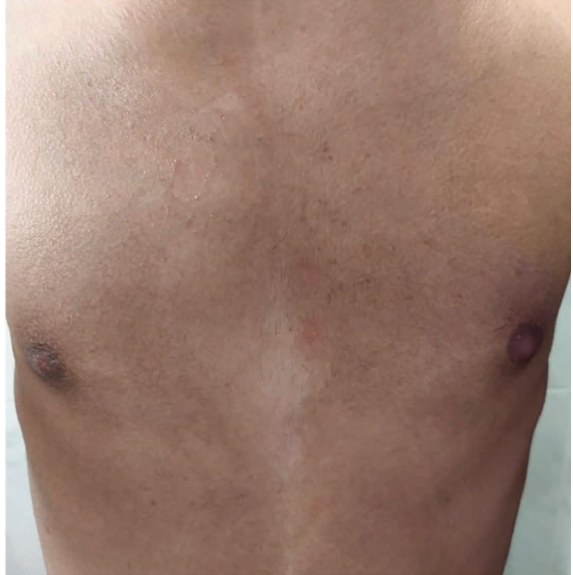
Figure 3: Resolution of the lesion within eight weeks of treatment.